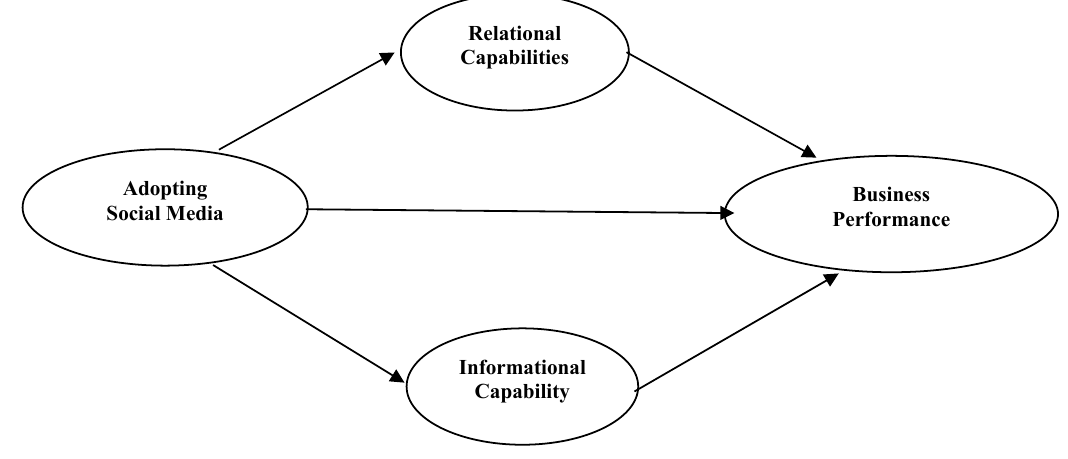
Fig. 1. Research concept